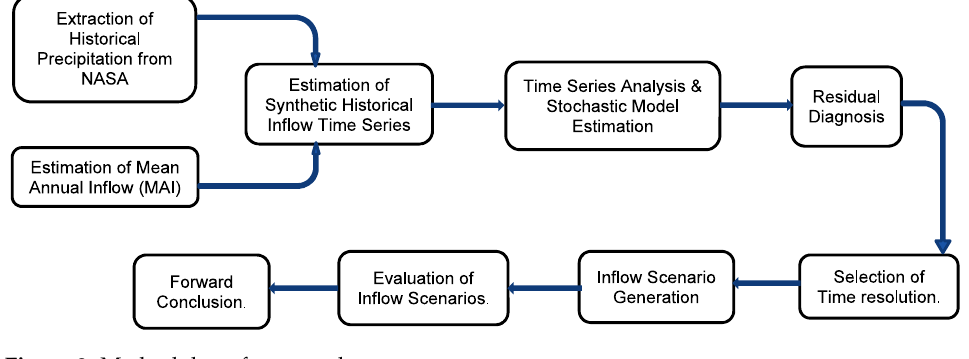
Figure 3. Methodology